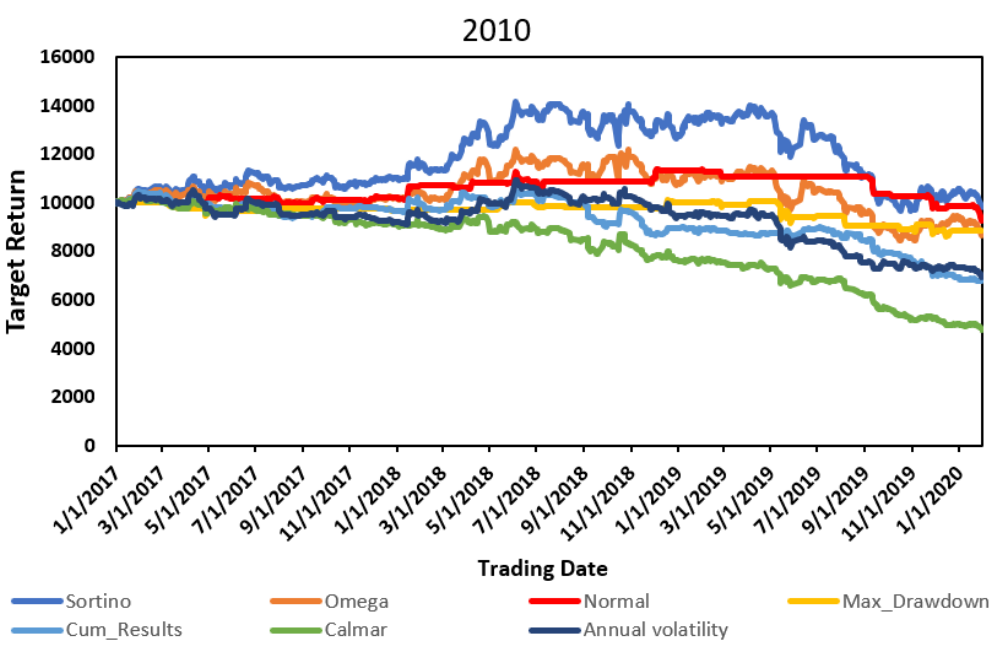
Figure 21. Outcome of 2010 stock target return during model training with different reward functions (Initial portfolio value $